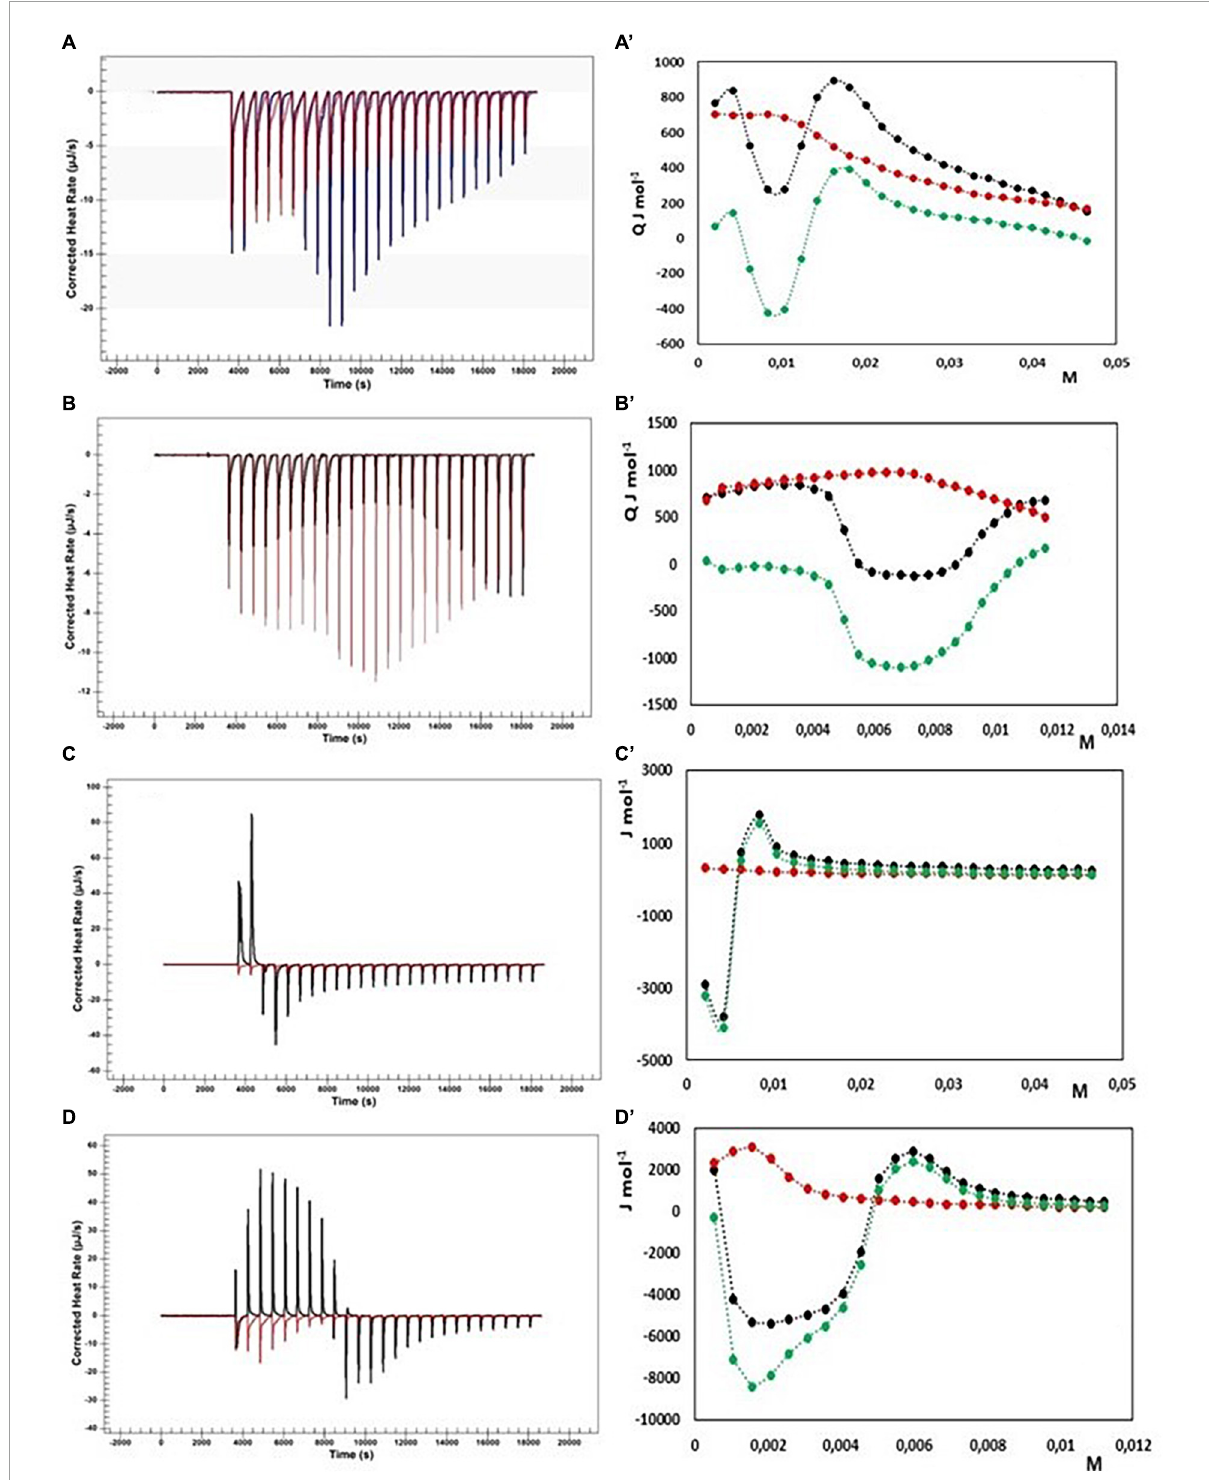
FIGURE7 Heat rate ( µ J s − 1 ) vs. time profiles obtained from 25 injection each of 10 µ L into a 960 µ L reaction cell filled with a chitosan solution 1 g L − 1 in 100 mM acetate buffer at pH = 3.0 (black) compared with the dilution of bile salt (red) in the same conditions, and (specified by a single quote mark) the dependence of the enthalpy change vs. bile salt concentration in the reaction cell for: (A) NaTC 200 mM; (B) NaTC 50 mM; (C) NaTDC 200 mM; (D) NaTDC 50 µ M. Black dots represent the interaction enthalpy between pectin and bile salt, the red dots the dilution enthalpies of bile salt and the green dots their